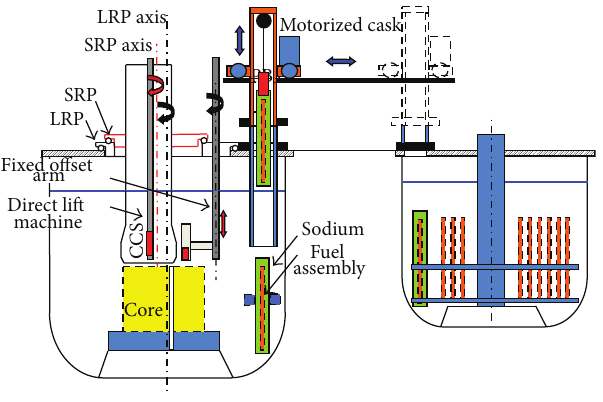
Figure 1: View of the fuel handling route called SRS.